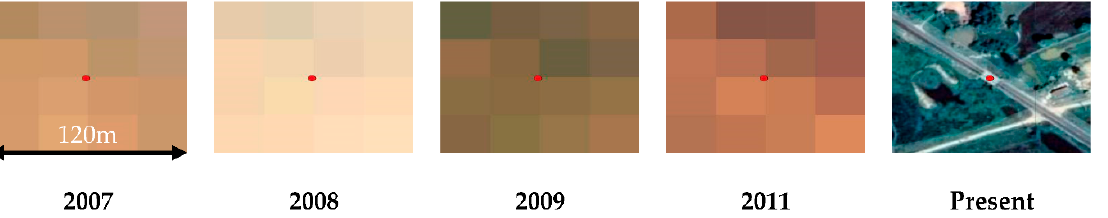
after 2014 (Figure 30).